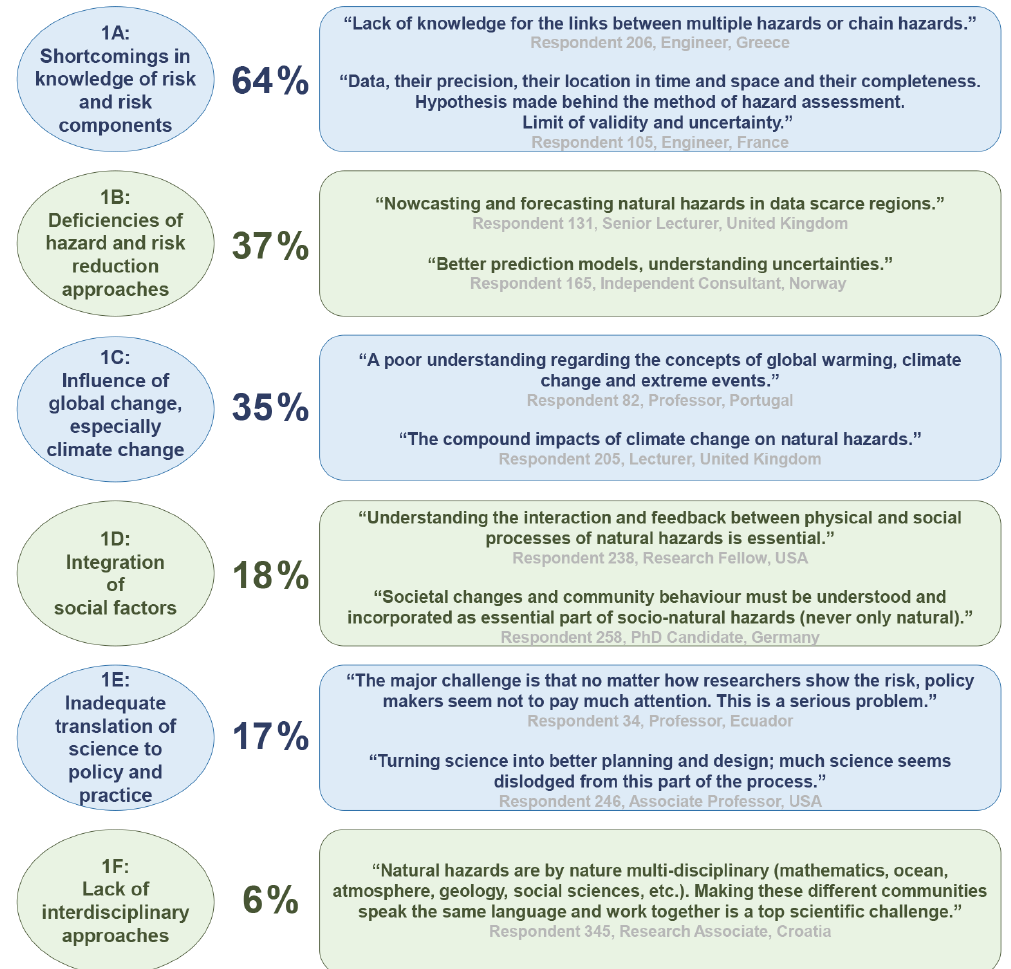
Figure 2. Six themes identified through thematic analysis of responses of 350 natural hazard community members to the NHESS survey question Q1 “what are the top three scientific challenges you believe are currently facing our understanding of natural hazards” along with example quotes. Percentages indicate the percentage of all respondents ( n = 350) whose answers were classified under a given